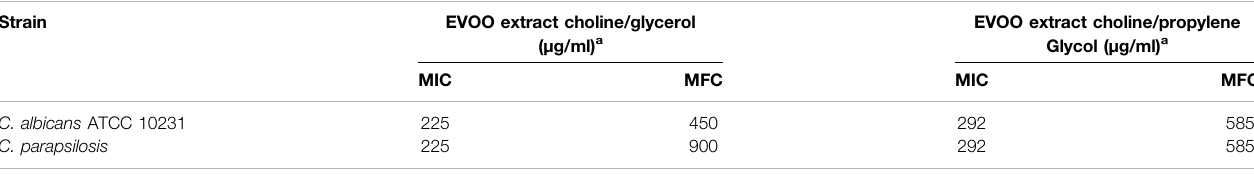
TABLE 5 | Antifungal activity (µg/ml) of EVOO extracts in NaDESs against Candida spp. Strain